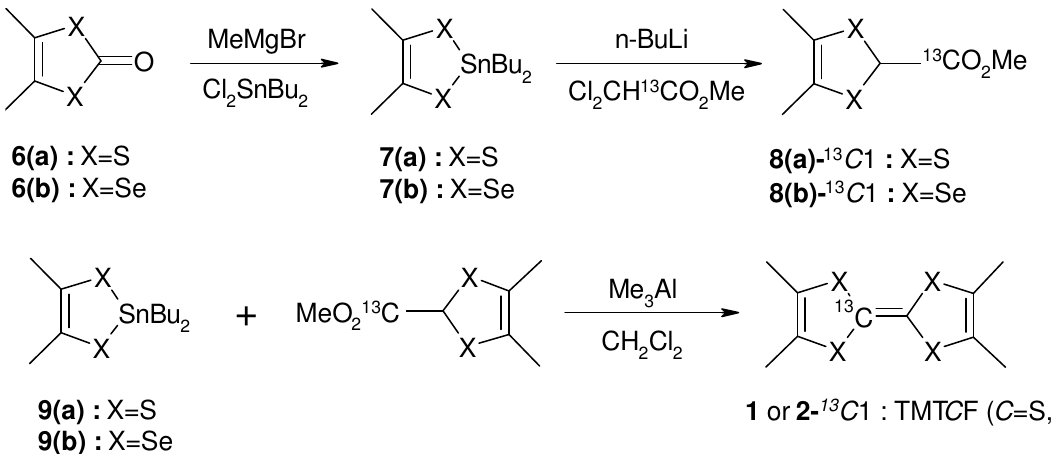
Figure 4. Synthetic route to prepare one-side 13 C-enriched TMT C F.